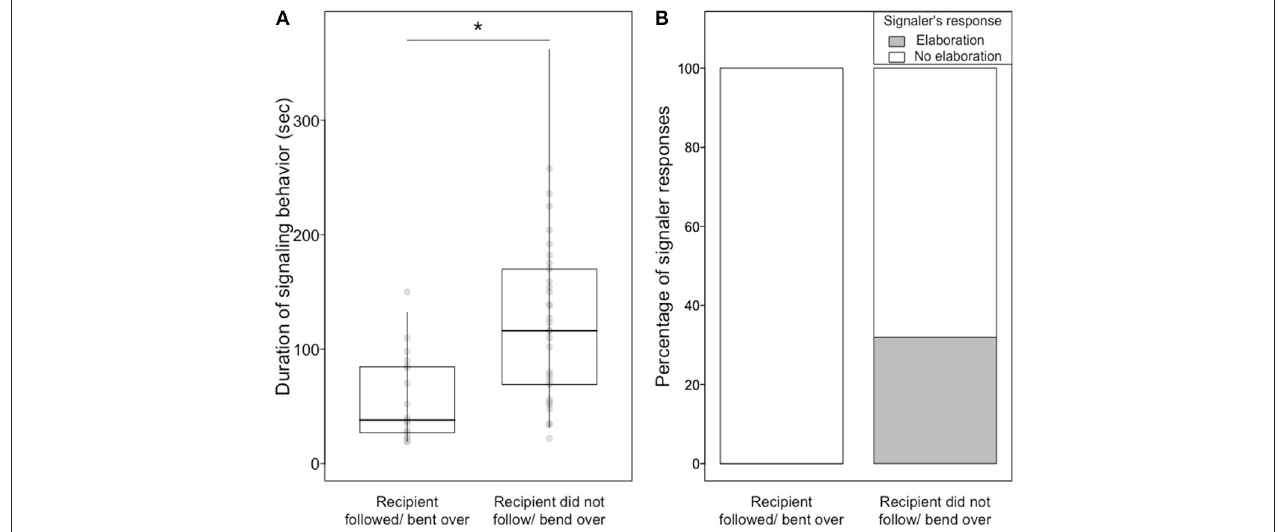
FIGURE 2 | (A) Median, quartiles, and quantiles (0.025 and 0.975) of the duration of object presentations according to whether the recipient followed the signaler/bent over in a copulation posture or did not, (B) percentage of episodes in which a signaler elaborated the signal and continued with the same signal according to whether the recipient followed the signaler/bent over in a copulation posture or did